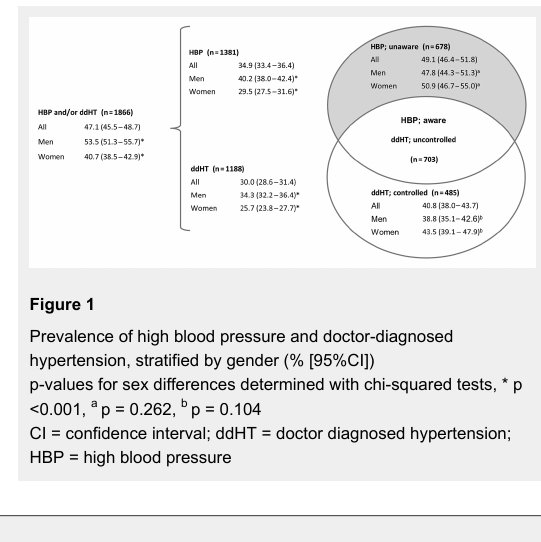
Table 1: Selected 2009 Swiss Society of Hypertension guidelines [15]. Lifestyle improvements for all Drug treatment